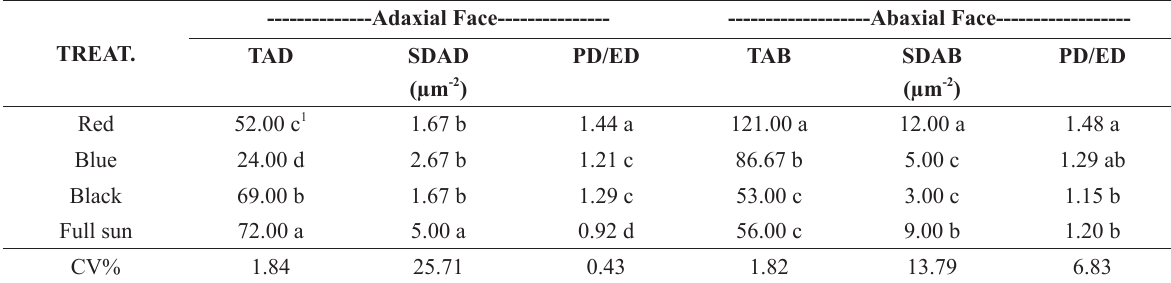
Number of trichomes in the adaxial epidermis (TAD), stomatal density in the adaxial epidermis (SDAD), polar and equatorial diameter of the stomata ratio (PD/ED) in the adaxial faces, number of trichomes in the abaxial epidermis (TAB), stomatal density in the abaxial epidermis (SDAB) and polar and equatorial diameter of the stomata ratio (PD/ED) in the abaxial faces of P. cablin cultivated under colored shade nets and under full sun.